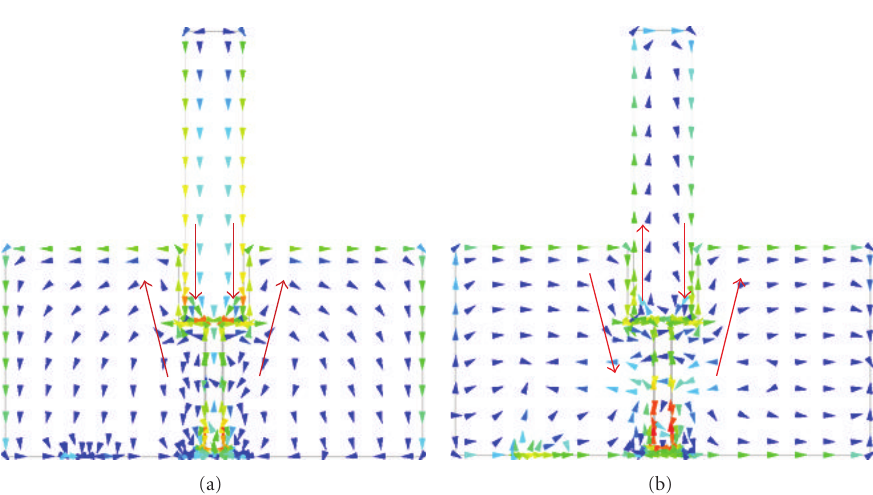
Figure 6: Current distribution in di ff erent modes, (a) CPW feeding and (b) microstrip feeding.